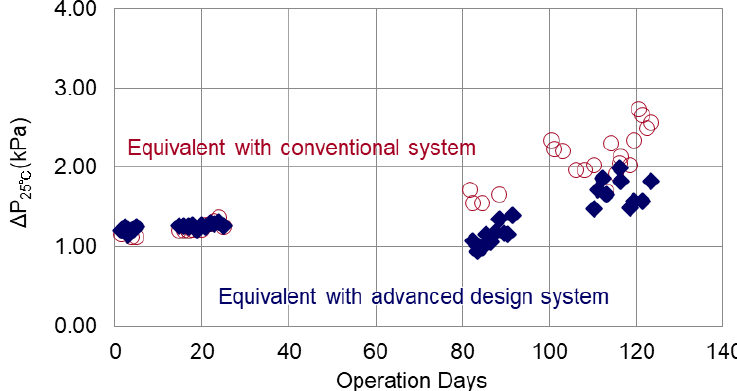
Figure 12. Changes in ΔP 25 of the flat sheet membrane cells.